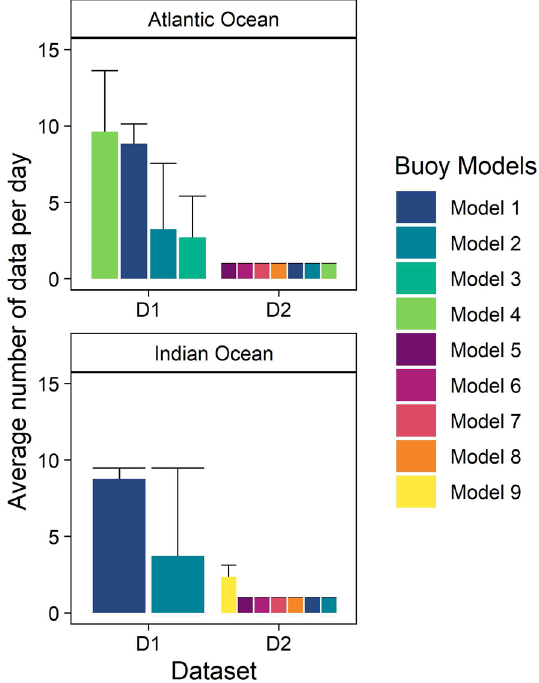
Fig. 2. Average number of location data provided per day by the different buoy models in the Atlantic and Indian Ocean datasets.